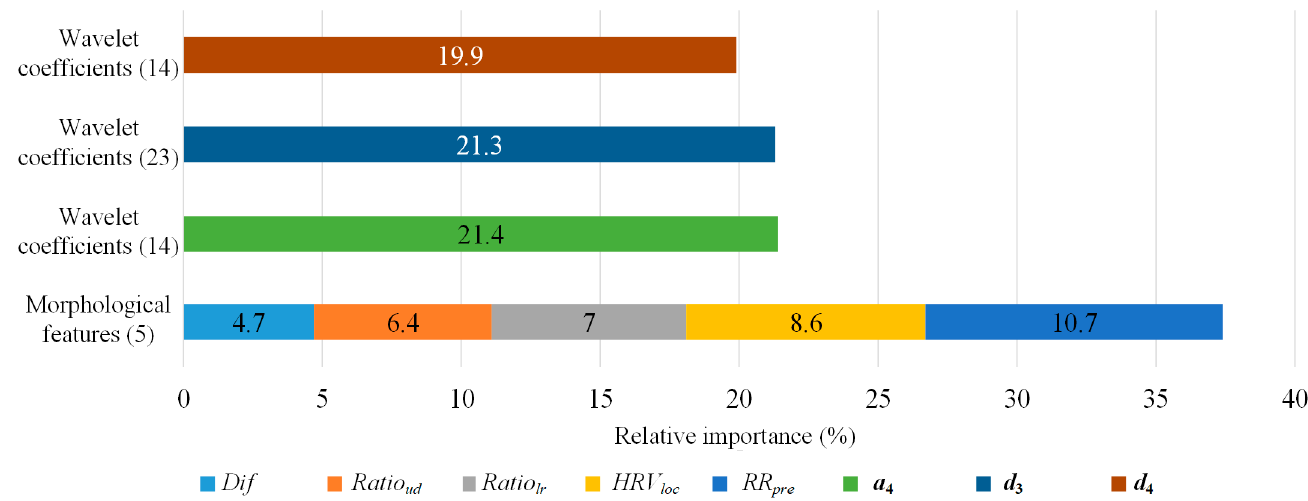
Figure 6. The relative importance of the features on the CPPDB. The number in the brackets is the dimension of features.